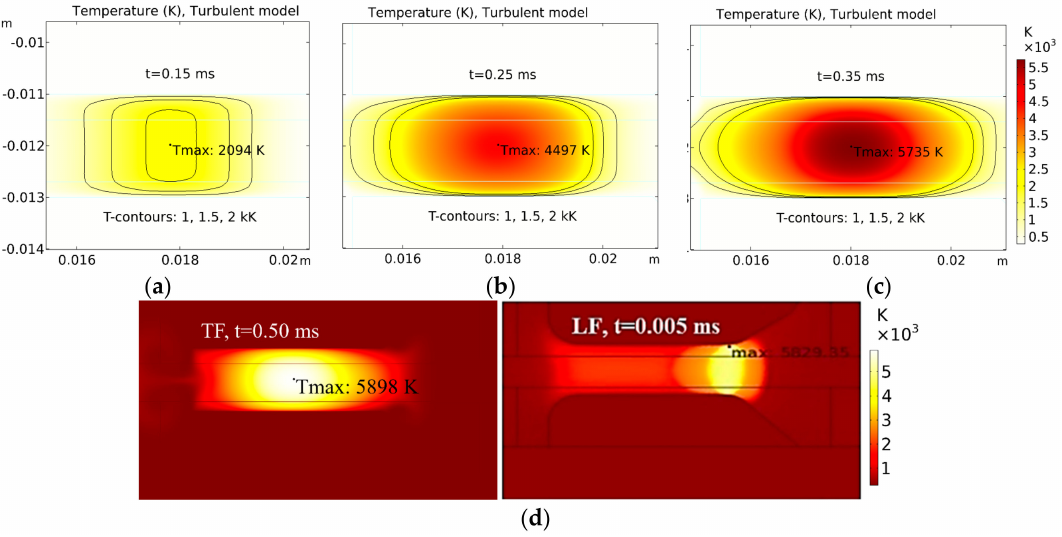
Figure 6. Arc temperature surface modeled in turbulent flows (TF) at ( a ) 0.15 ms, ( b ) 0.25 ms, ( c ) 0.35 ms, and ( d ) Comparison of arc shape in the laminar and TF model for an arc of 200 A peak